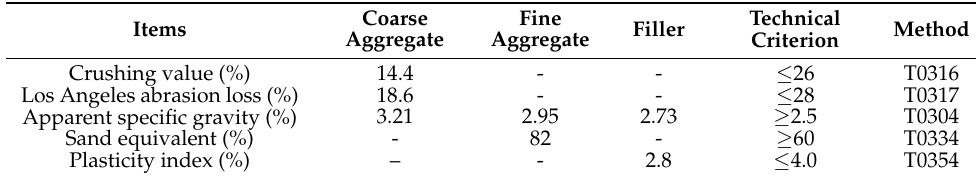
Table 1. Properties of aggregates and filler.